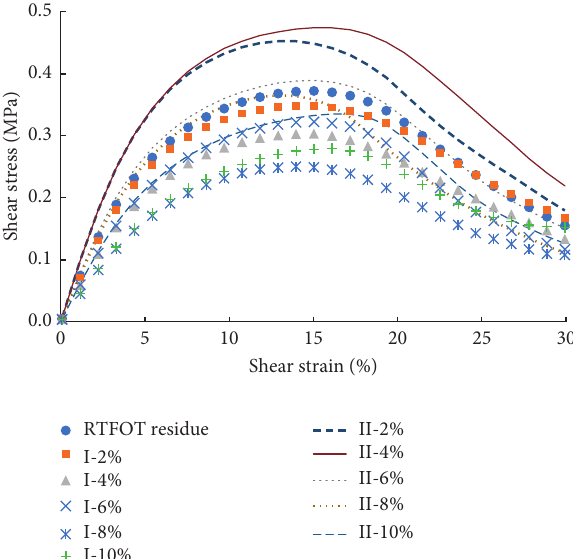
Figure 9: Stress-strain curves for the rejuvenated SBS-modified asphalt